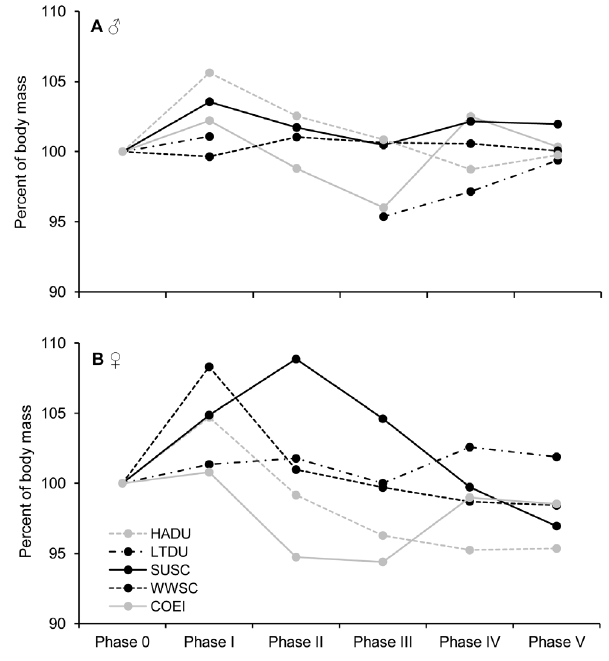
Figure 4. Inter-specific body mass variation during remigial moult. Changes in mean body mass of birds (as percentage of initial weight) based on the percentage growth of the 9 th primary for 5 seaduck species; Harlequin Ducks (HADU), Long-tailed Ducks (LTDU), Surf Scoters (SUSC), White-winged Scoters (WWSC) and Common Eiders (COEI) with ( A ) representing males and ( B ) females. Phase 0 corresponds to the value of initial weight before the shedding of flight feathers, Phase I represents feather emergence and the start of feather growth, Phase II corresponds to the period of fast feather growth rate and where maximal growth rate is reached, Phase III is the period of the first slowing down of growth rate, Phase IV corresponds to the second slowing down of growth rate and the period during which birds are able to fly again, Phase V is the end of the remigial moult when final length of P9 is reached.